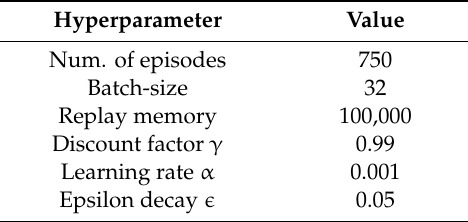
Table 6. Hyperparameters for the